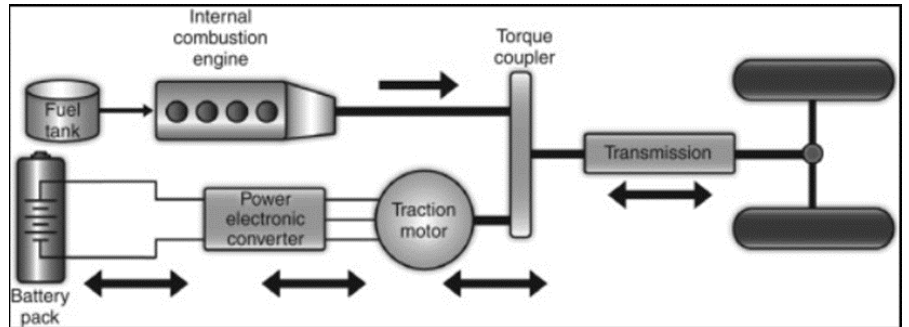
Figure 5. Parallel hybrid configuration [69].